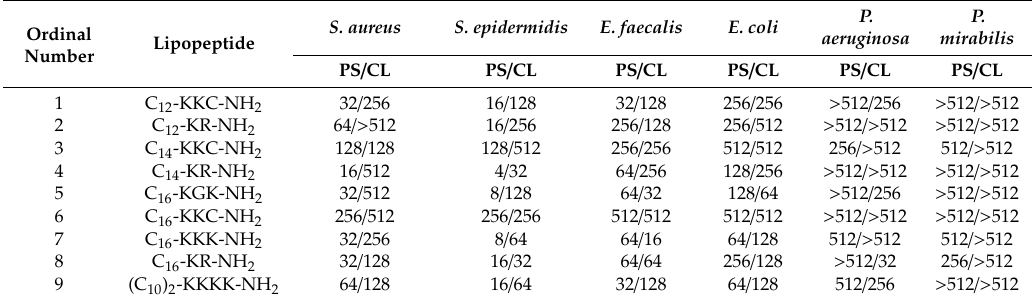
Table 5. Minimum biofilm eradication concentration (MBEC) of the lipopeptides ( µ g / mL) for PS and